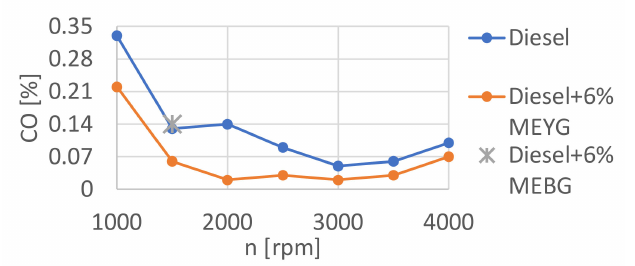
Figure 9. The CO emissions at full engine